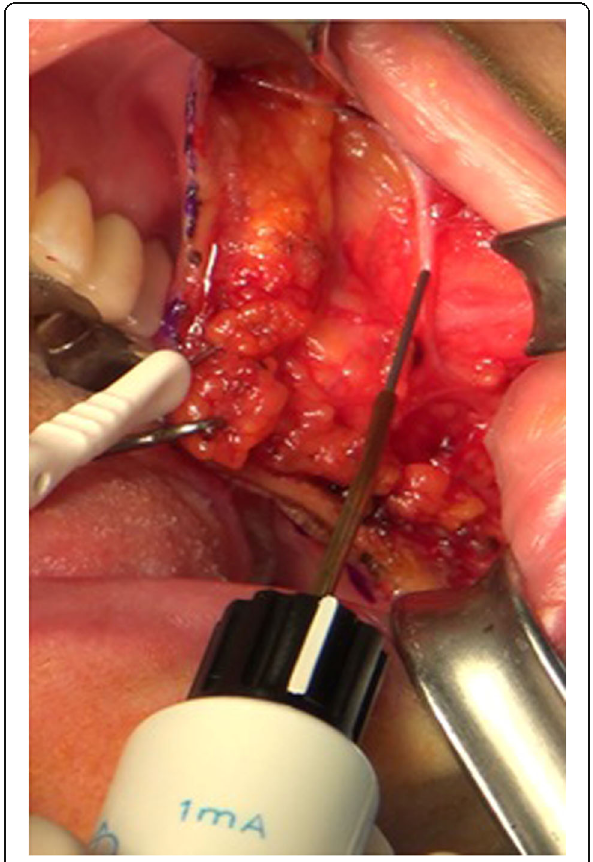
Fig. 2 Identifying the buccal branch near the parotid duct using a nerve